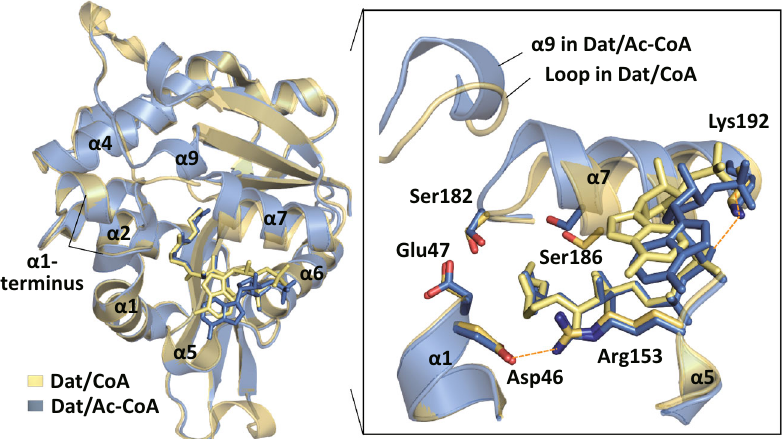
Fig. 4 Active site is fi ne-tuned by the acetyl group. Structural comparison of Dat/CoA complex (yellow, PDB code: 5GI5) and Dat/Ac-CoA complex (blue, PDB code:3TE4) reveals different positions of α 7 and loop – α 9 changes. Residues are shown as sticks. Salt bridges in Asp46 – Arg153 and Lys192 – CoA moiety are shown in orange dashed lines.